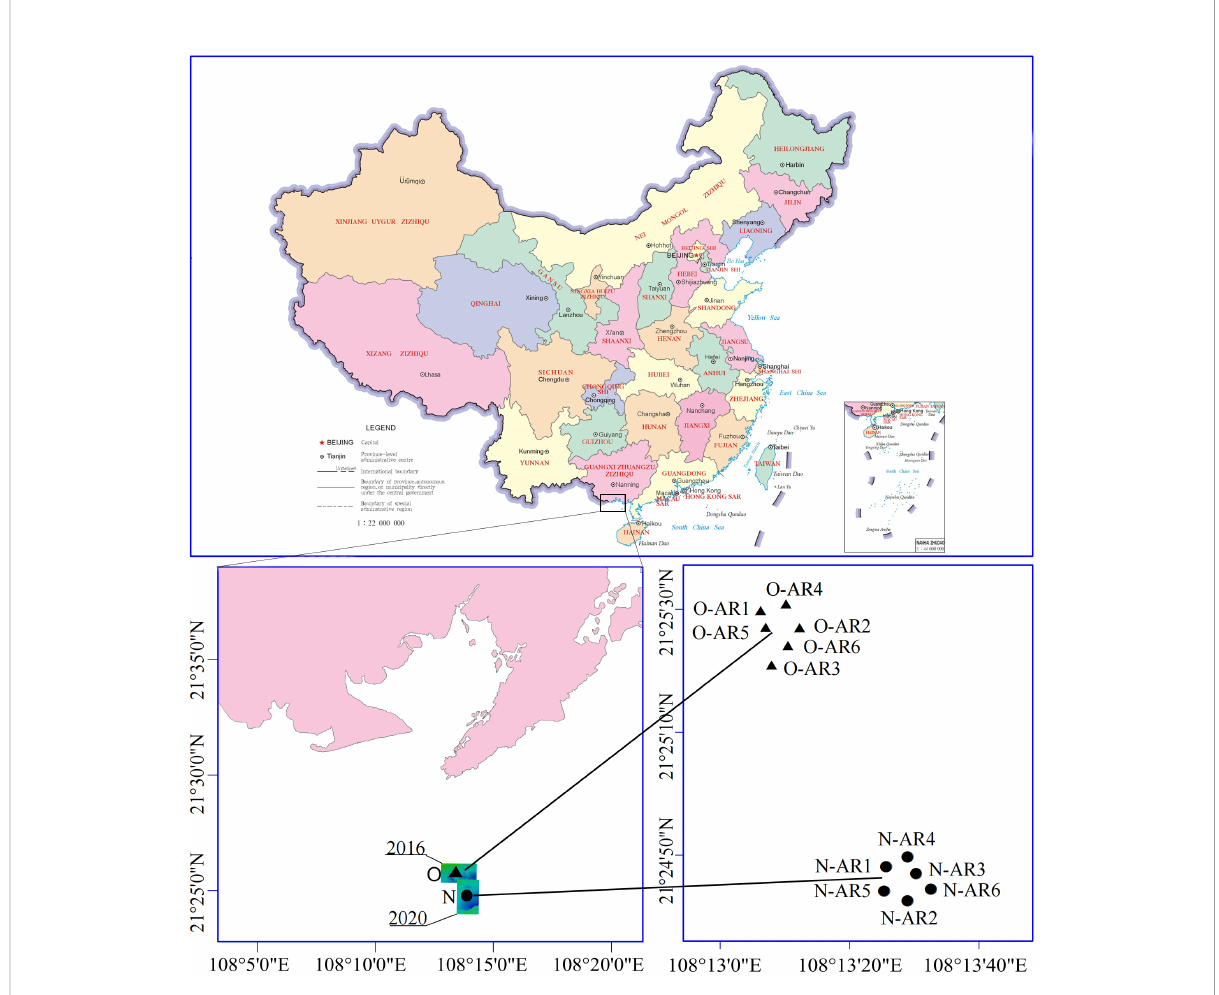
FIGURE 1 Sampling sites in Bailong Pearl Bay, Fangchenggang City, Guangxi Zhuang Autonomous Region, China: N-ARs (constructed in 2020) and O-ARs (constructed in 2016). Different shapes (circles and triangles) represent ARs with different construction